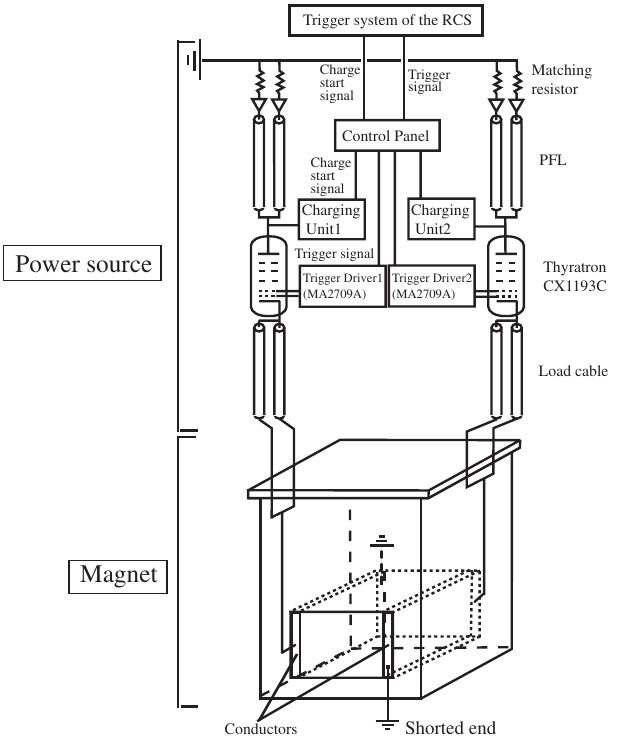
FIG. 1. Outline structure of the kicker